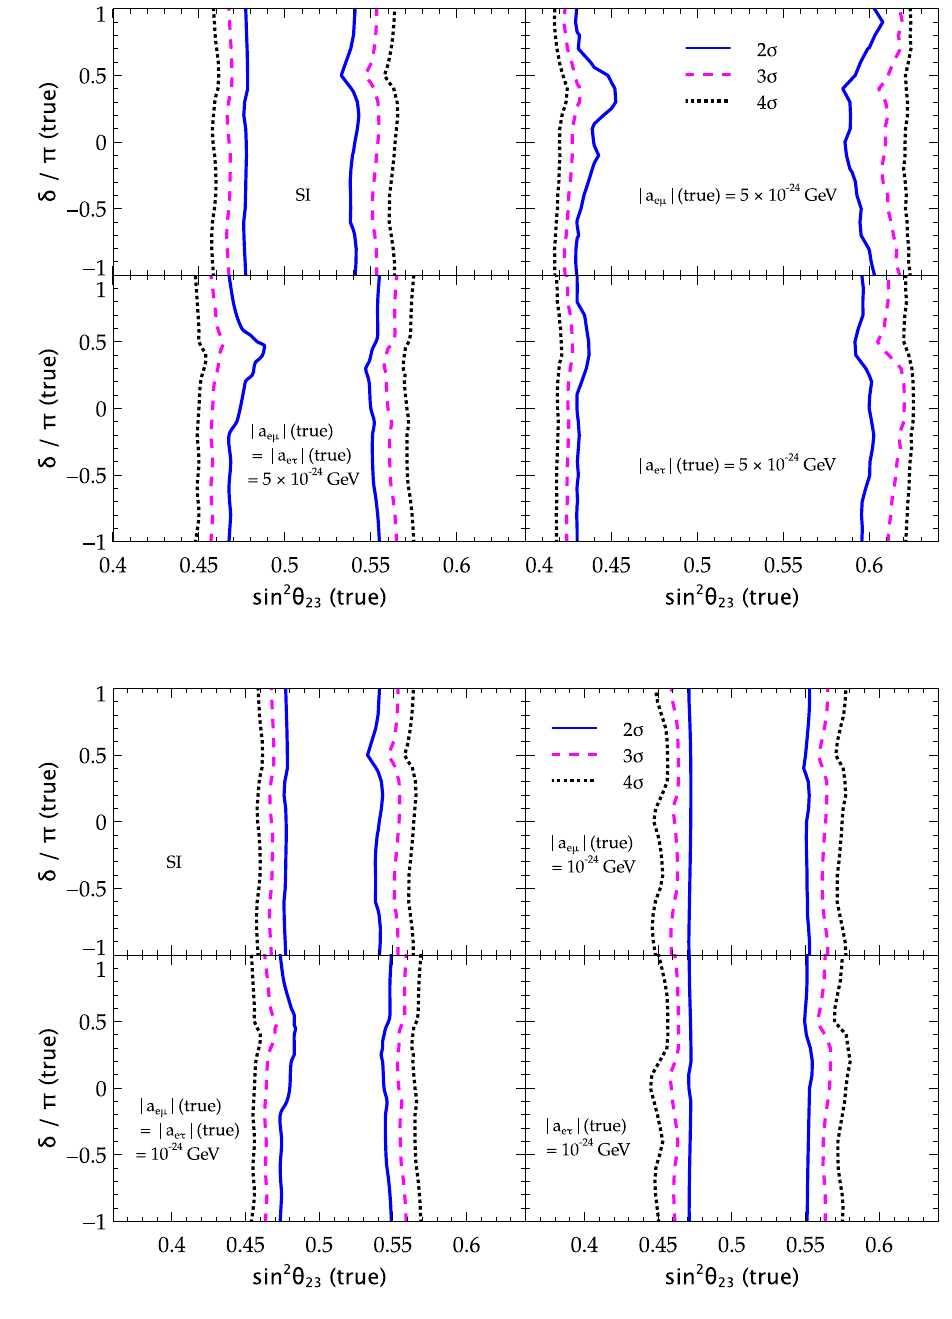
Fig. 4 Octant discovery potential in [sin 2 θ 23 – δ ] (true) plane at 2 σ (solid blue curves), 3 σ (dashed magenta curves), and 4 σ (dotted black curves) confidence levels (1 d.o.f.) assuming NO both in data and theory. We consider four different scenarios: the SI case (top left panel), the SI+LIV case with a e μ (top right panel), the SI+LIV scheme with a e τ (bottom right panel), and the SI+LIV framework with both a e μ and a e τ present together (bottom left panel). In all the panels, the strength of the true LIV parameter is assumed to be 5 × 10 − 24 GeV. See text for marginalization and other details